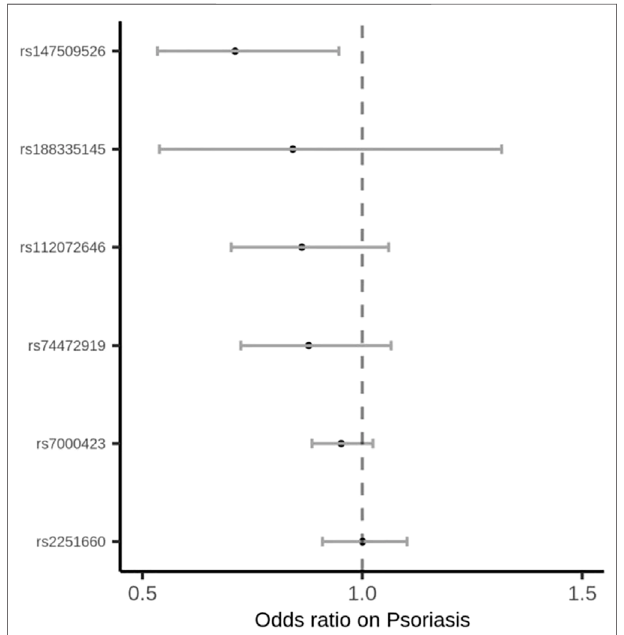
FIGURE 1 | Forest plot of the effects of IVs for RANTES on the risk of psoriasis vulgaris.